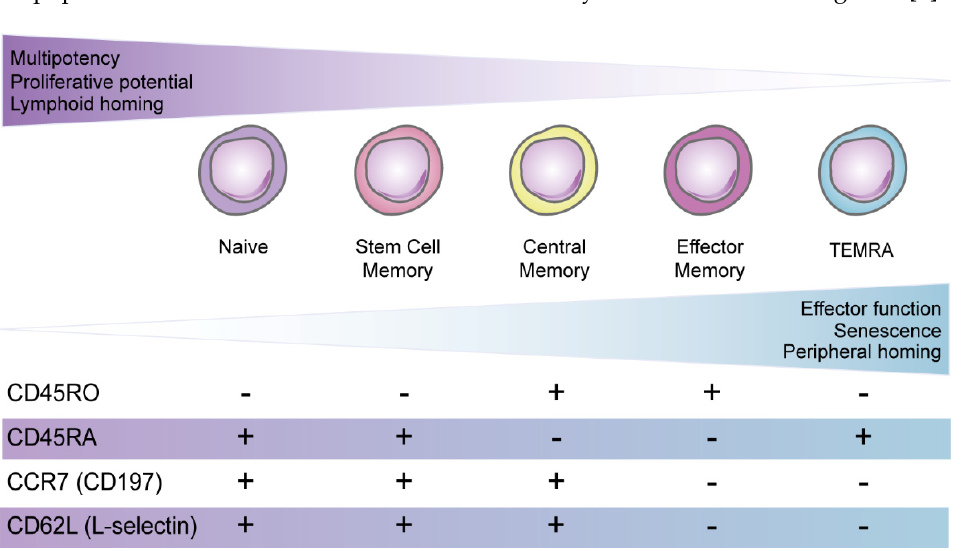
Figure 1. Differentiation markers characterizing various CD8 + T cell populations. Changes in surface marker expression of CD45RO, CD45RA, CCR7 and CD62L define stages of CD8 + T cell differentiation from naïve to terminally differentiated effector memory (TEMRA) CD8 + T cells. Gradient triangles indicate preferential functions of CD8 + T cell subpopulations.